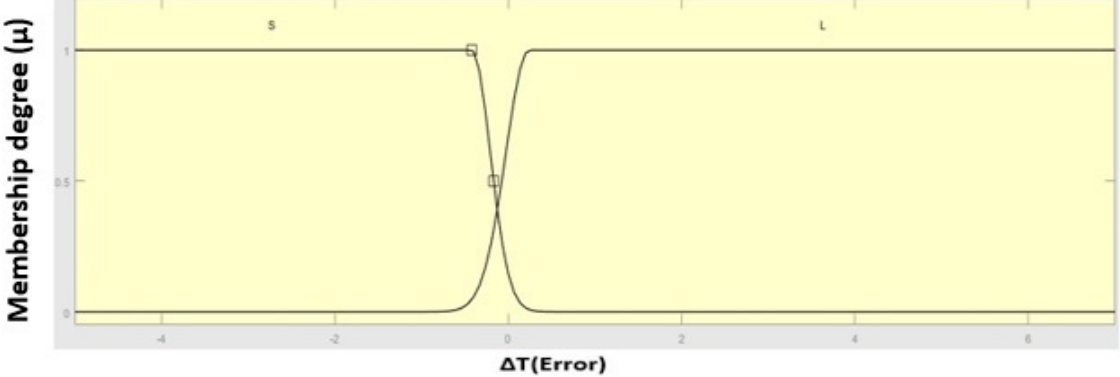
Figure 10. Membership functions of the Δ T (Error).